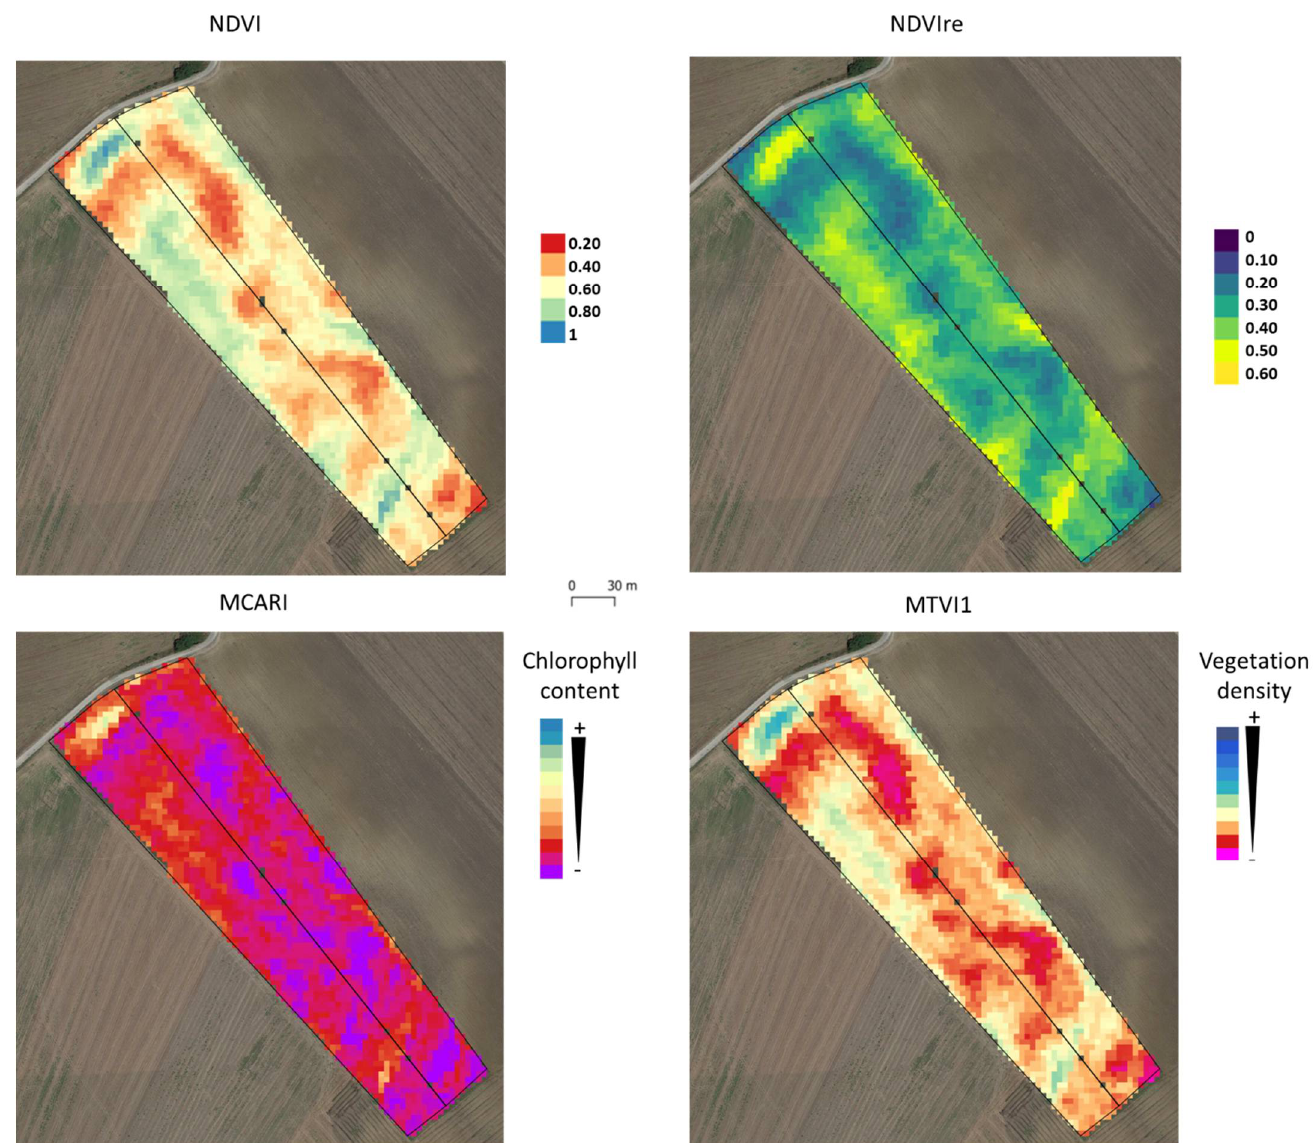
Figure 11. Maps of multispectral indices obtained from elaboration of the RapidEye satellite data for the CA site (municipality of Venosa) with Saragolla Lucana durum wheat cultivation for the NDVI, NDVI-RE, MCARI, and MTVI1. The black line circumscribes the sub-areas managed with conservative (soil ripping, right side) and conventional (deep tillage, left side) practices.